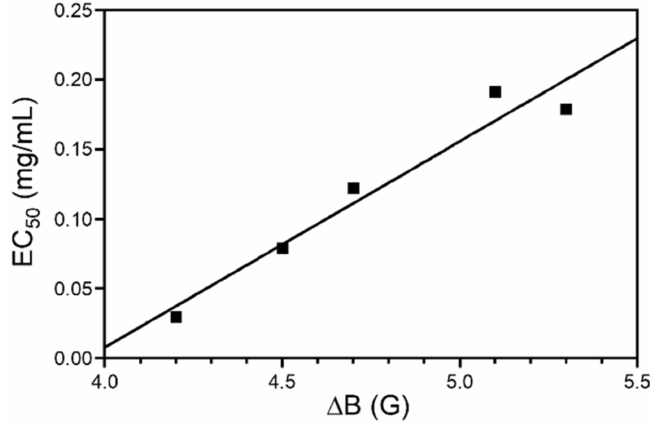
Figure 5. Correlation between antioxidant properties (expressed as EC 50 values determined in the DPPH assay) and ∆ B values (determined by EPR spectroscopy) of nut shell lignins (EC 50 = ( − 0.58 ± 0.10) + (1.15 ± 0.02) ∆ B, R 2 = 0.94).